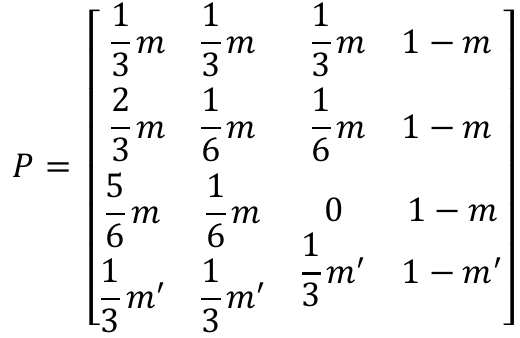
Figure 8. Transition probability matrix.